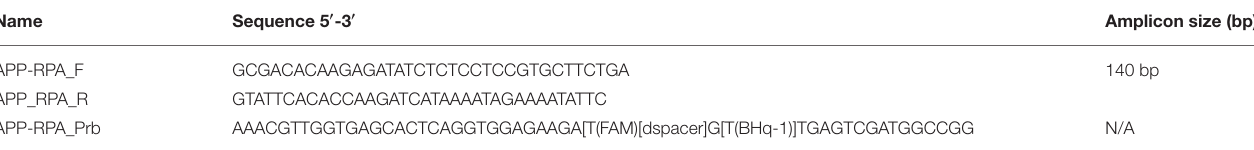
TABLE 1 | RPA primers and probes used in this